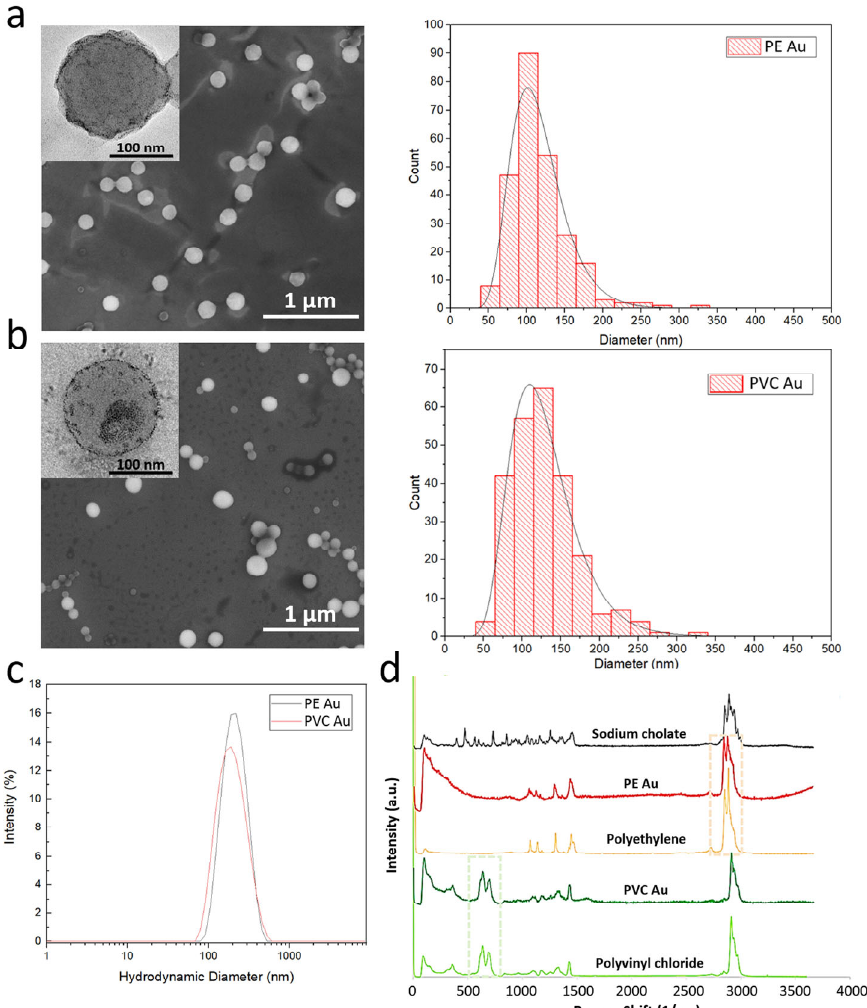
Figure 1. Scanning electron microscopy images of gold-doped polyethylene and polyvinyl chloride nanoplastics (images ( a , b ), respectively) and their mean diameter distribution, evaluated by the manual measurement of a diameter of at least 200 particles. The insets show a high-magnification transmission electron microscopy image of the single nanoplastics, in which the ultrasmall gold nanoparticles are visible as small dark spots. ( c ) DLS size intensity spectra of PE Au (blue line) and PVC Au (red line) samples, dispersed in MilliQ water. ( d ) Raman spectra of polypropylene and polyvinyl chloride polymers powders, sodium cholate hydrate powder, and PE Au and PVC Au